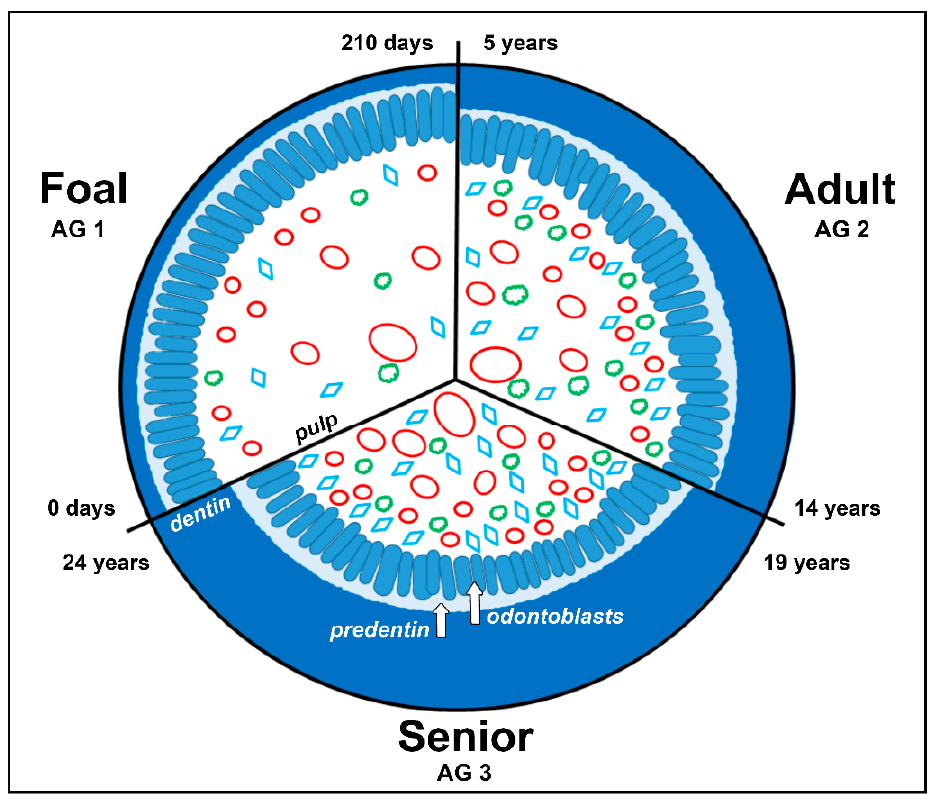
Figure 8. Schematic illustration of a decreasing pulp cavity of an equine tooth due to continued deposition of secondary dentin throughout age (0 to 24 years). Red ovals in different sizes: blood vessels, green clouds: nerve fibers, blue rhombus: fibroblastic